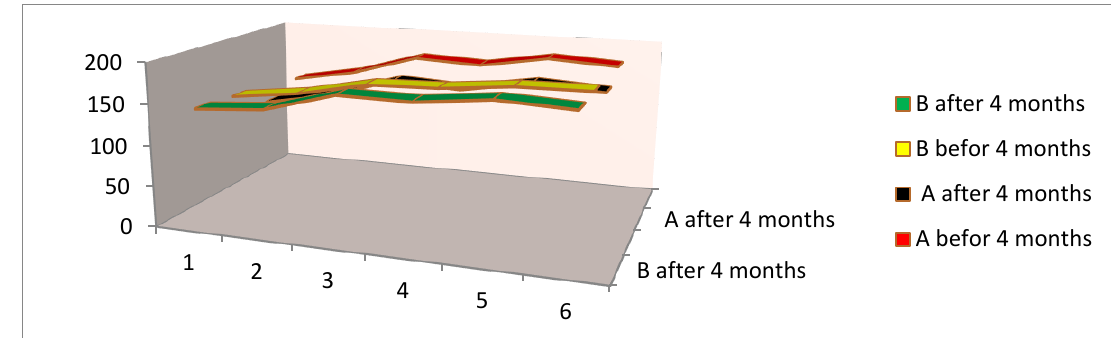
Fig. 2. Comparison of the two groups' mean LDL (mg/dl) with time (baseline and after four months)